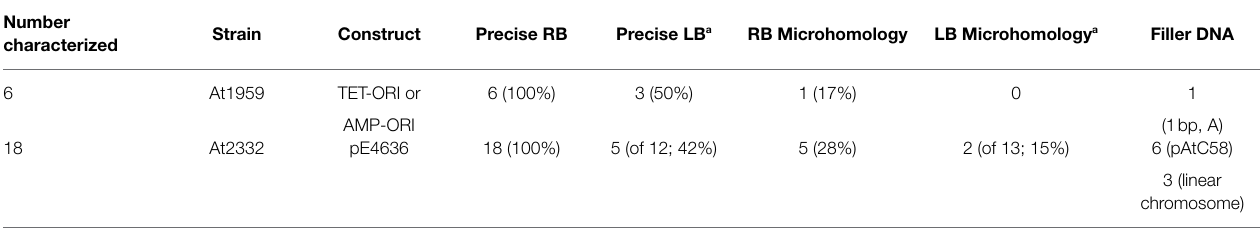
TABLE 6 | T-DNA junctions of T-circles from Agrobacterium benthamiana using virD2 ω mutant Agrobacterium strains. Number